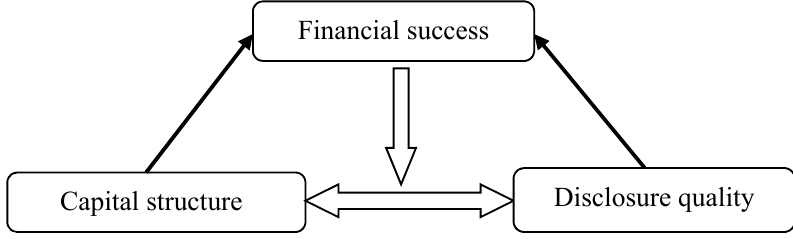
Fig. 1. The structure of the proposed study (Myers, 1984)